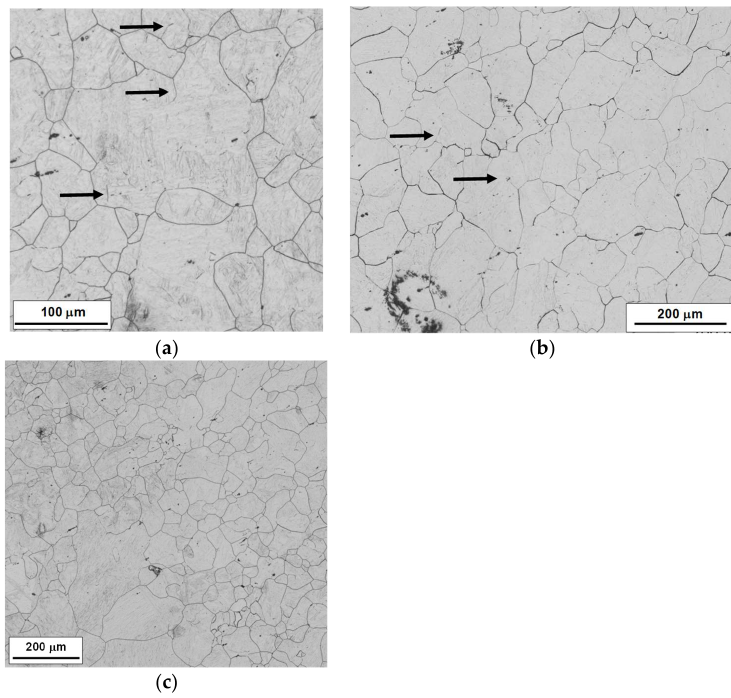
Figure 3 . Optical micrographs of the martensitic sample quenched from recrystallized austenite revealed by Bechet-Beaujard etching [6] in the areas corresponding to the EBSD scans of Figure 2. ( a ) 350 × 350 μm 2 ; ( b ) 800 × 700 μm 2 ; and ( c ) 900 × 900 μm 2 . In ( a , b ), the arrows represent boundaries which show weaker contrast and/or which do not close to define grains.